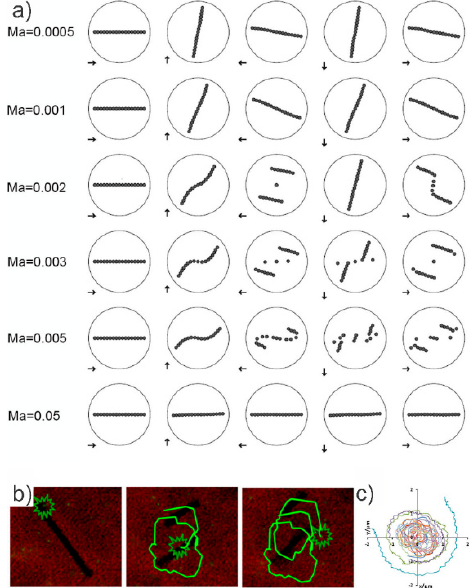
Figure 6. ( a ) Dynamics of the chain at six Mason numbers. The arrows depict the magnetic field directionality; image reproduced with permission from [112] published by the American Physical Society, 2007. ( b ) Particle tracing results obtained for periodic chain breaking and chain reformation. The induced motion of a tracer particle following the fluid at different time steps [116]. ( c ) The overall trajectories of the tracer particles, starting at different radial distances from the center (0, 0) [116]. ( b ) and ( c ) reproduced with permission from [116], published by Springer Nature, 2013.